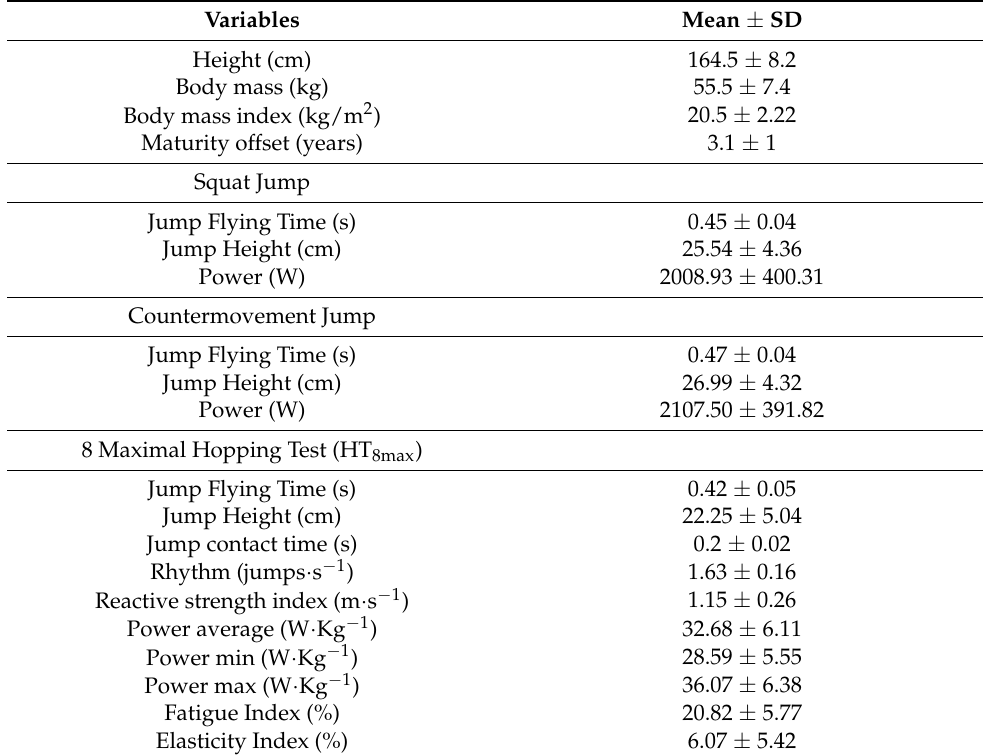
Table 1. Demographic and jumping test characteristics of the participants.